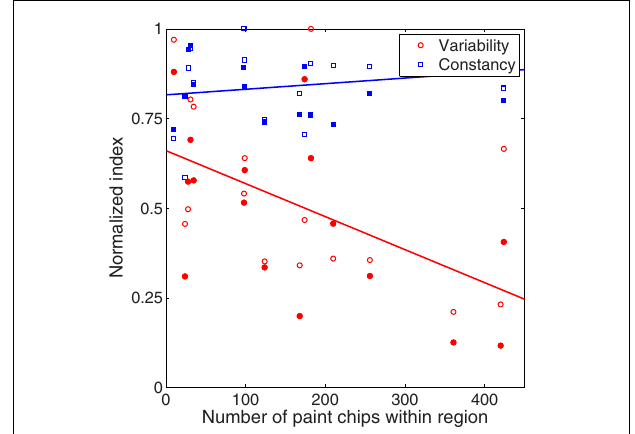
FIGURE 8 | Relationship between variability in color matches (x-axis) and color constancy index (y-axis) in illumination (unfilled circles) and joint (filled circles) conditions. Solid black line is best fit line through all data.